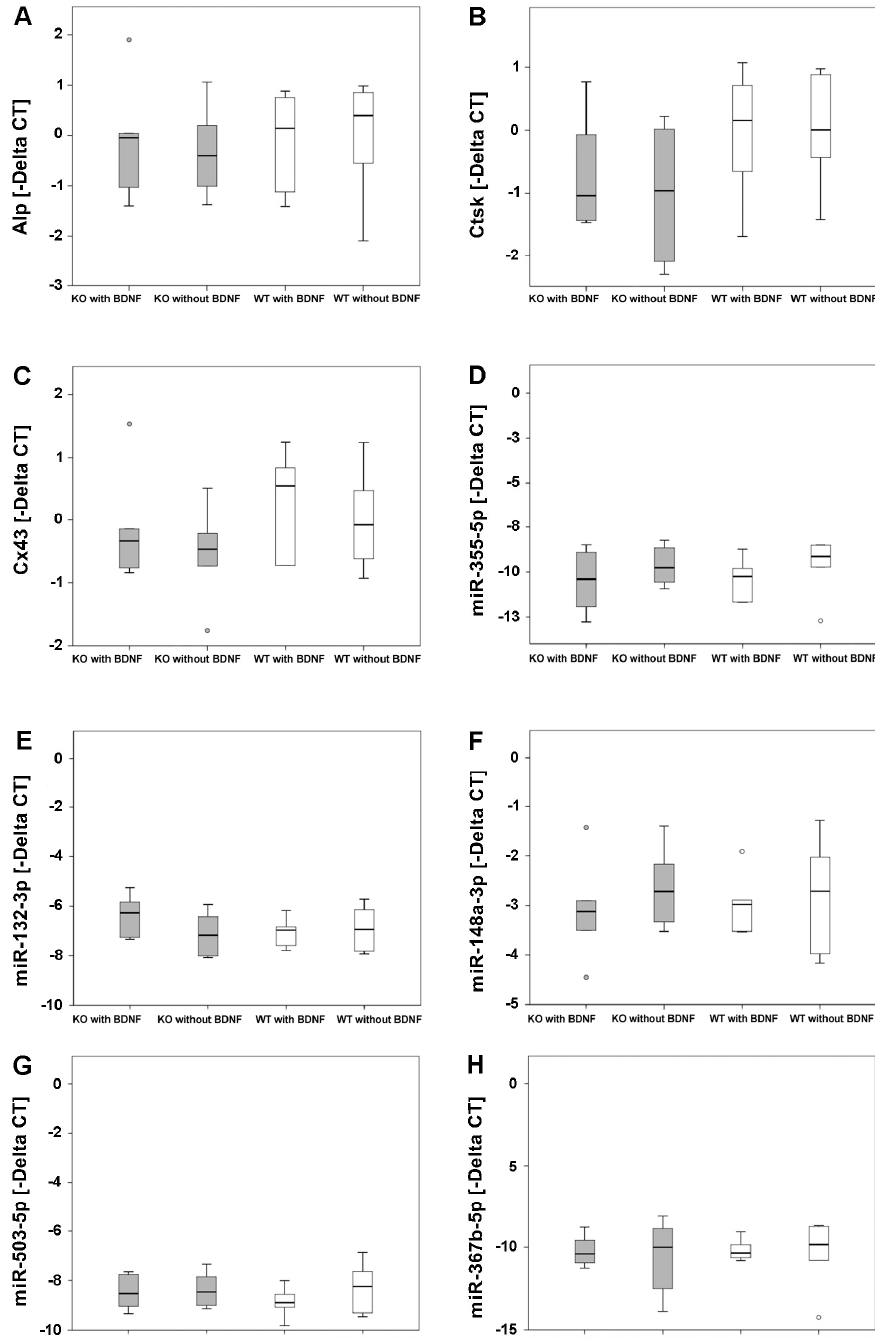
Figure 1. mRNA expression of Alp ( A ), Ctsk ( B ) and Cx43 ( C ), microRNAs miR-335-5p ( D ), miR-132- 3p ( E ), miR-148a-3p ( F ), miR-503-5p ( G ) and miR-376b-5p ( H ) at the bone implant interface in femurs of M3 mAChR KO and corresponding WT mice. The grey and white circles indicate outliers.